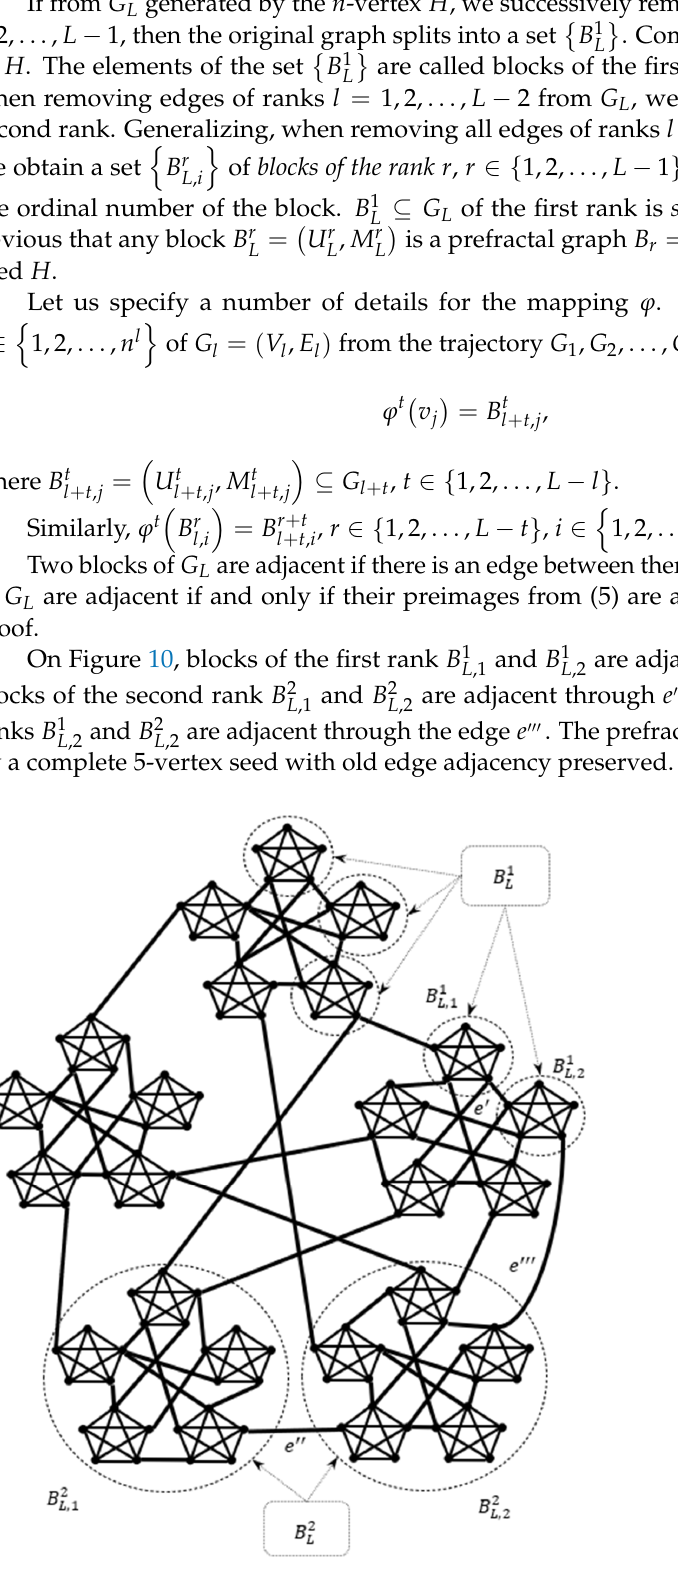
Figure 10. Blocks of prefractal graph G 3